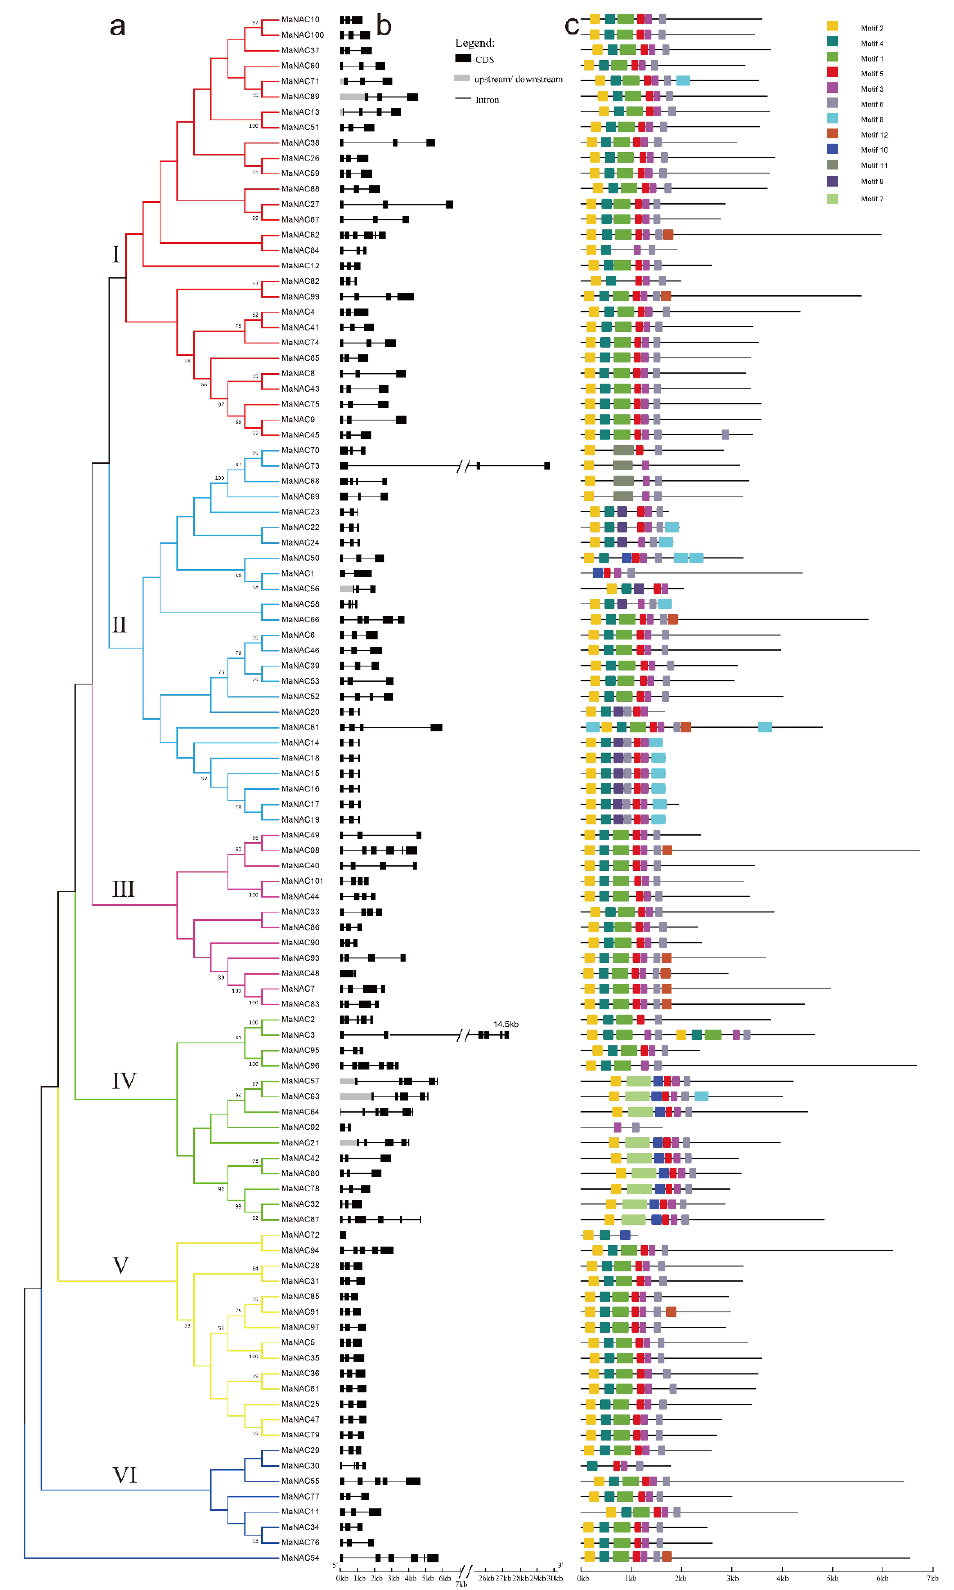
Figure 4. Phylogenetic relationships, gene structure and motif compositions of M. albus NAC members. ( a ) Phylogenetic tree of MaNAC proteins. The tree was constructed via MEGA 7.0 with the NJ method (bootstrap, 1000 replicates). Bootstrap values greater than 50% are shown on the nodes. ( b ) Intron/exon structures of MaNAC genes. ( c ) MaNAC protein motifs.